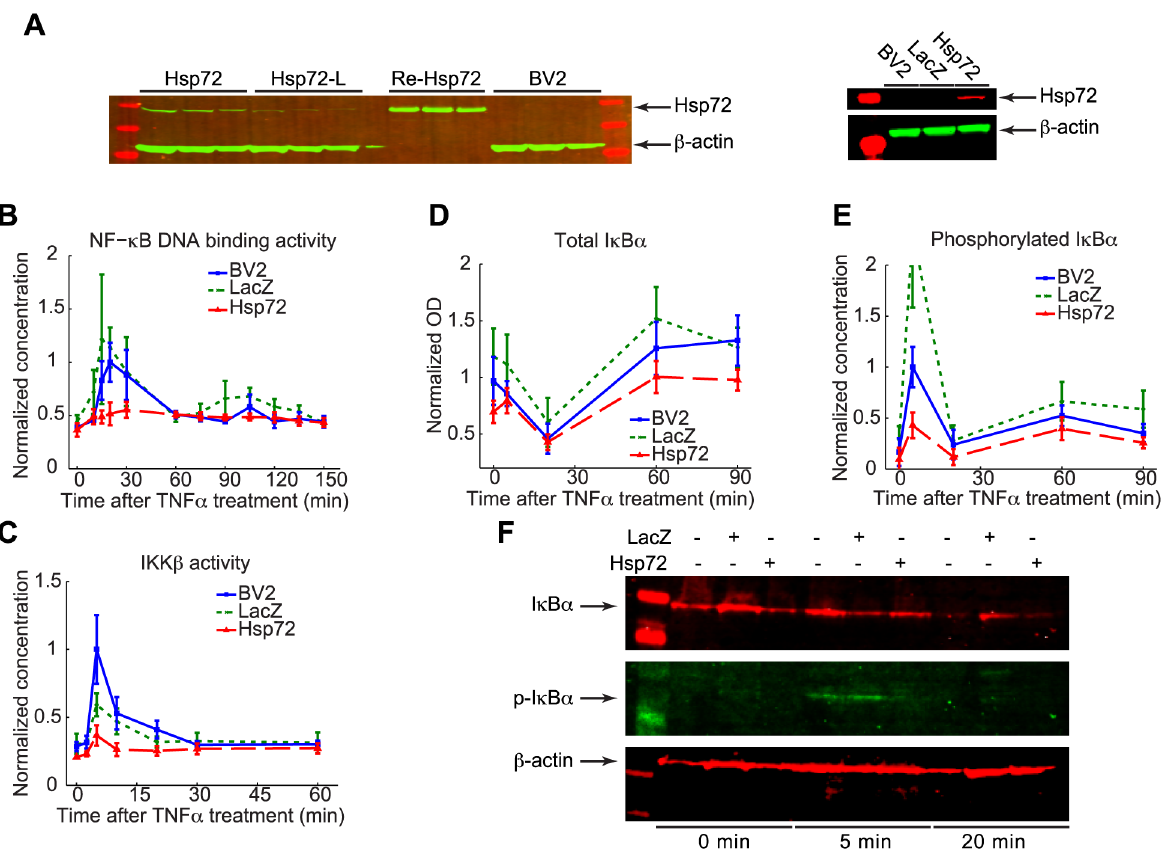
Figure 1. NF- k B signaling in response to TNF a stimulus is attenuated in BV2 cells overexpressing Hsp72 cells. A. Western blot assays of BV2 cells stably overexpressing Hsp72 at high levels (Hsp72) and low levels (Hsp72-L) compared with recombinant Hsp72 (Re-Hsp72), control cells (BV2), and control cells transfected with LacZ vector (LacZ). B. NF- k B p65/RelA DNA binding activity is significantly reduced in Hsp72 cells at 15, 20, 30, 105 min time points compared to other cell types. Concentrations were measured with ELISA and normalized with respect to the average measured p65 activity in BV2 cells at 20 min (n=4 at 150 min for LacZ, n=6 for all other time points and cell types). C. IKK b kinase activity following treatment with 10 ng/ml TNF a at 0 min is significantly lower in Hsp72 cells at 0, 2.5, 5, 10 and 20 min. Concentrations were measured with ELISA and normalized with respect to average IKK activation in BV2 cells at 5 min (n=6 at each time point). D. Total I k B a protein is reduced in Hsp72 cells compared to other cell types at 0, 60 and 90 min. Total I k B a levels were measured using ELISA optical density (OD) readings and normalized with respect to the average OD in BV2 cells at 0 min (n=9 at each time point). E. Ser-32 phosphorylated I k B a is lower in Hsp72 cells than other cell types at 5, 20, 60 and 90 min. Concentrations were measured with ELISA and normalized with respect to the average level in BV2 cells at 5 min (n=9 at each time point). F. Western blot assays of total and Ser-32 phosphorylated I k B a protein from whole cell extracts.